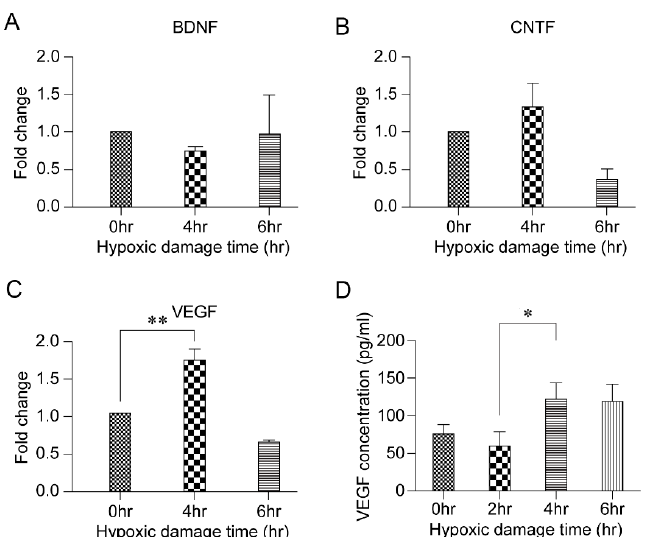
Figure 3. Vascular endothelial growth factor (VEGF) and hypoxic damage. ( A, B and C ). Fold changes in the expression of brain ‐ derived neurotrophic factor (BDNF), ciliary neurotrophic factor (CNTF), and VEGF after hypoxic preconditioning of retinal ganglion cells (RGCs) for 4 and 6 h. Data in the columns indicate the mean fold changes ± SD. ( D ) VEGF concentration after hypoxic preconditioning of RGCs for varying lengths of time (2, 4, and 6 h). Data in the columns indicate the mean concentrations ± SD. Statistically significant differences in the mRNA fold change and VEGF concentration are indicated (* p < 0.05 and ** p < 0.01).